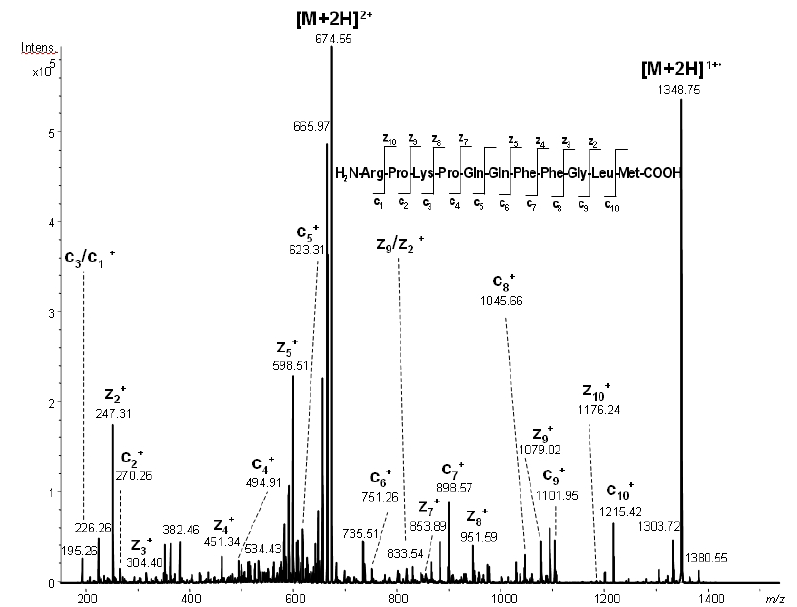
Figure 2. NanoMate-ETD MS 2 o f the [M+2H + ] 2+ ion at m/z 674.55 corresponding to Substance P. Acquisition time 30 s. Inset: fragmentation scheme by